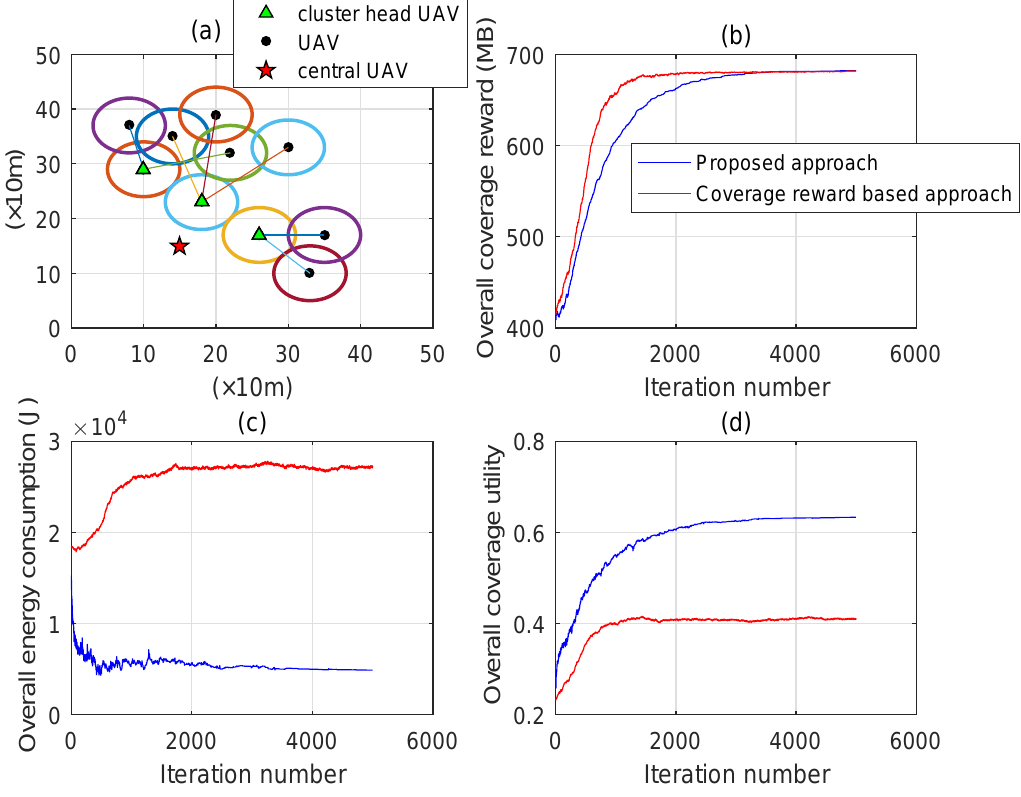
Figure 6. The performance convergence graph of the proposed model ( ρ = 1 × 10 − 5 ). ( a ) Diagram of UAV deployment and coalition formations; ( b ) Convergence performance of overall coverage reward; ( c ) Convergence performance of overall energy consumption; ( d ) Convergence performance of overall coverage